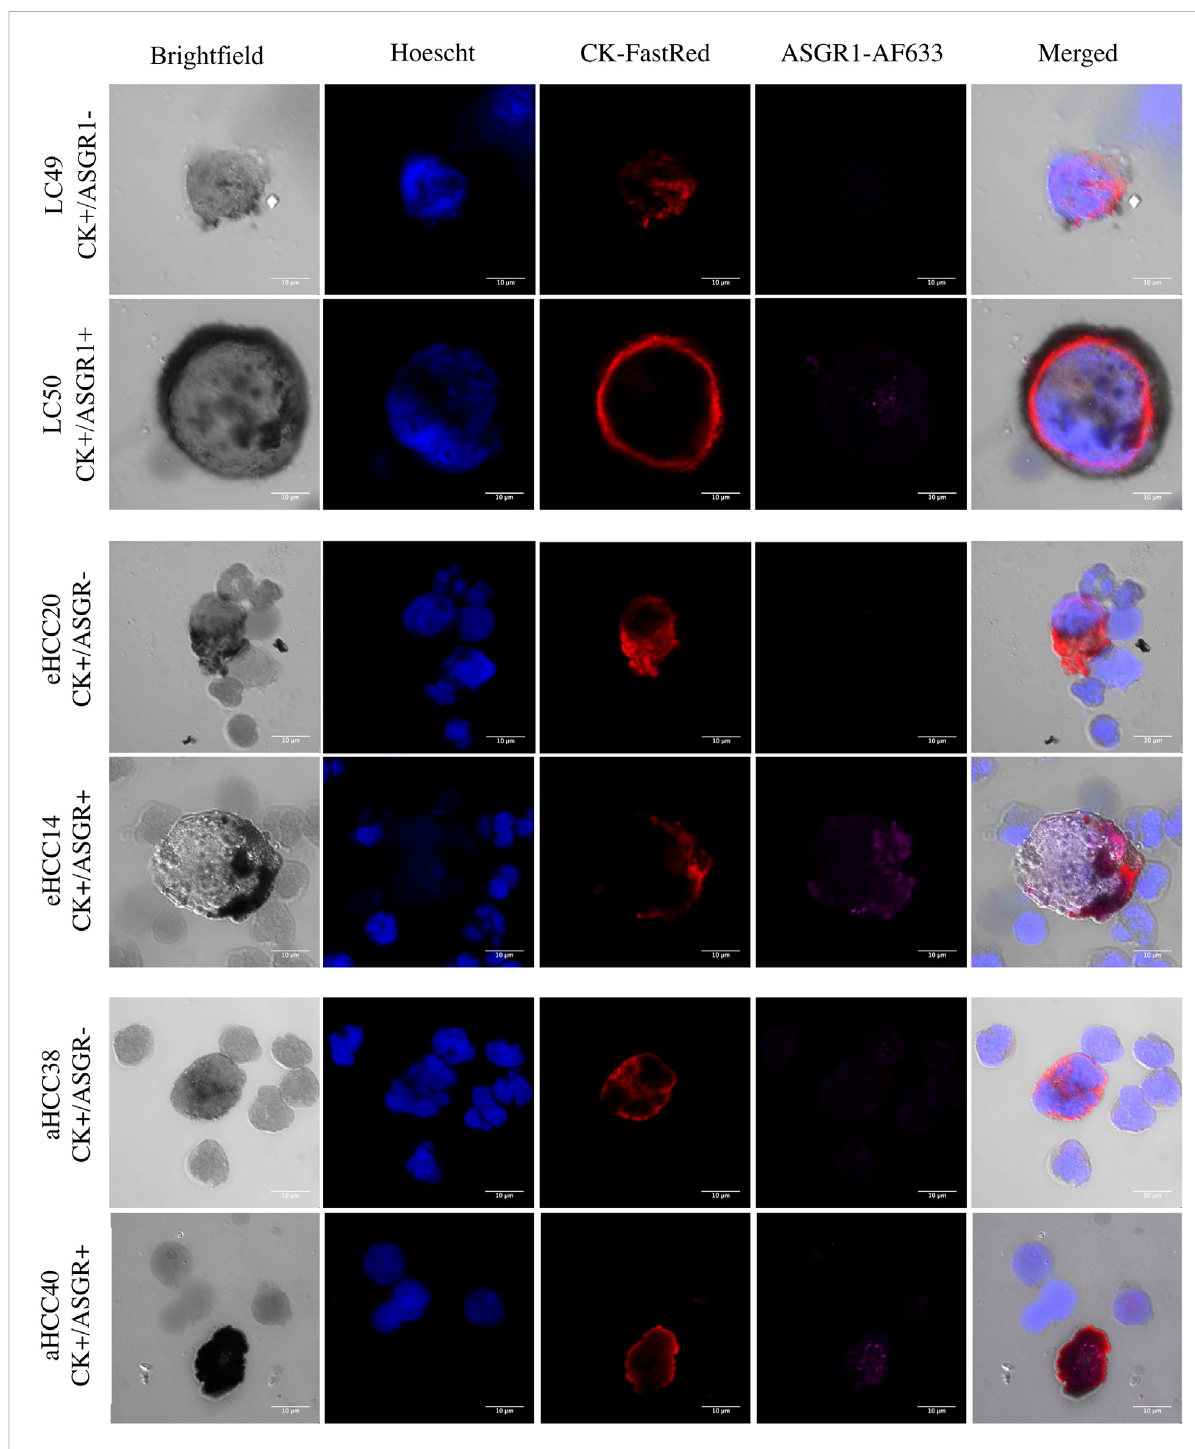
FIGURE 1 CECs heterogeneity in patients with liver cirrhosis or HCC. Heterogeneity is shown with respect to Cytokeratin (CK) and ASGR1 expression in two LC (liver cirrhosis) patients (top), two eHCC (early HCC) patients (middle) and two aHCC (advanced HCC) patients (bottom). In each case, one CEC positive for the two markers (CK and ASGR1) and one CEC negative for ASGR1 are shown. Hoechst is used as nuclear